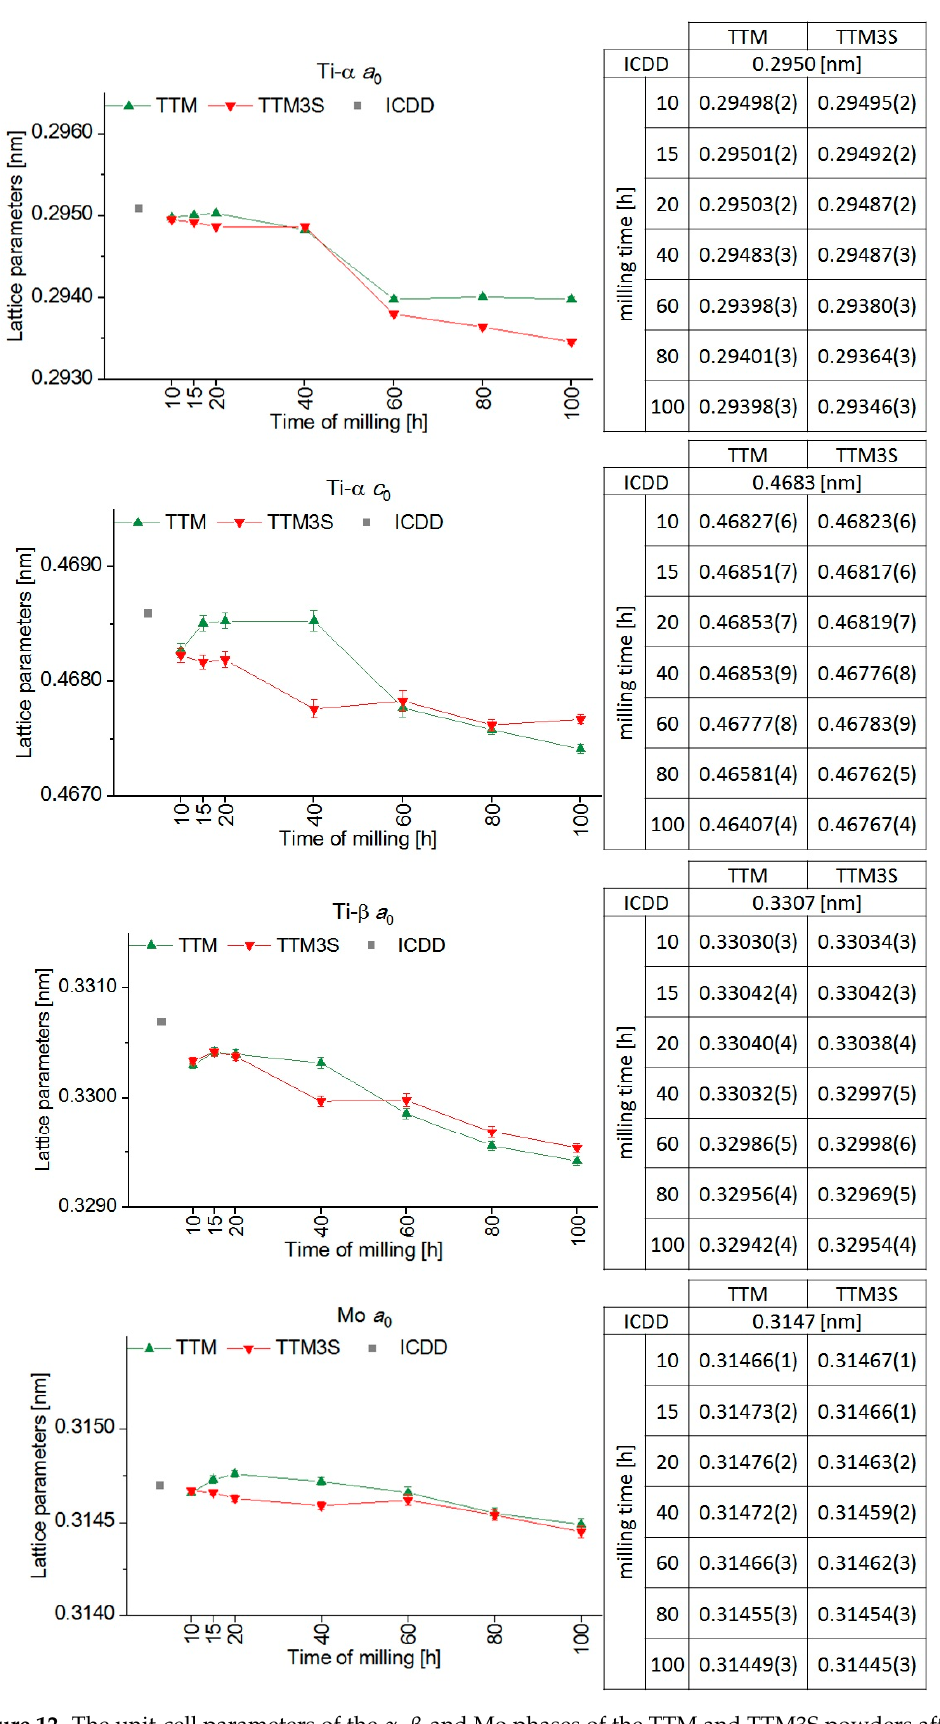
Figure 12. The unit ‐ cell parameters of the α , β and Mo phases of the TTM and TTM3S powders after Figure 12. The unit-cell parameters of the α , β and Mo phases of the TTM and TTM3S powders after 10, 15, 20, 40, 60, 80 and 100 h of milling. 10, 15, 20, 40, 60, 80 and 100 h of